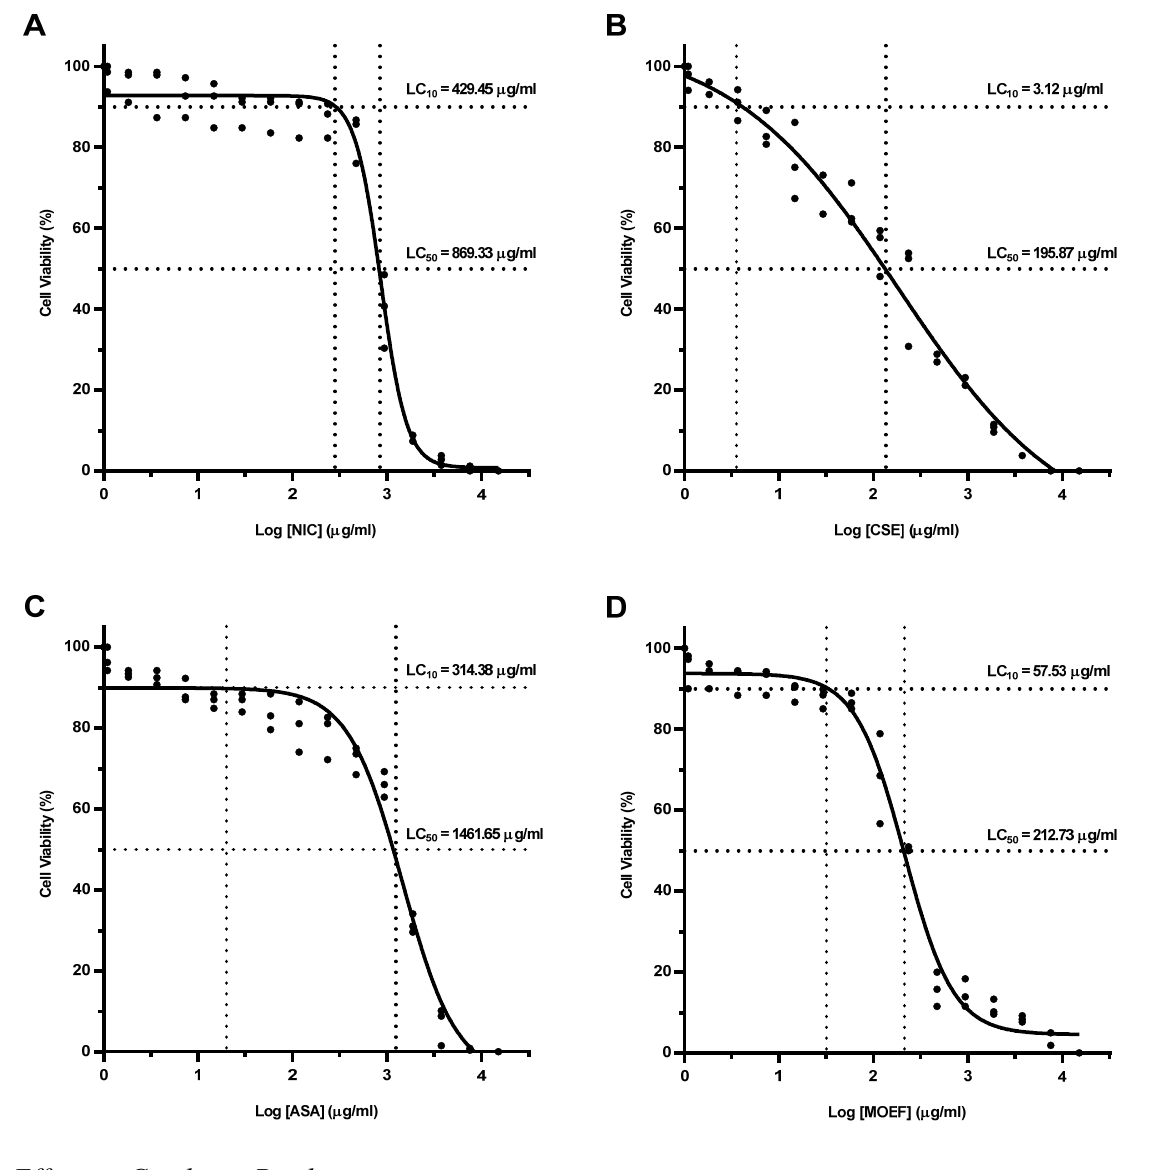
Figure 2. Dose-response curves of each test substances, showing LC nicotine ( A ); CSE; cigarette smoke extract ( B ); ASA; Aspirin ( C ); and MOEF; ethyl acetate fraction from Moringa oleifera extract ( D ). Cells were treated with 2-fold pre-diluted substances for 12 h and tested for their cellular cytotoxicity by neutral red uptake cytotoxicity bioassay. Data of cell viability in triplicate were used to calculate LC LC of each substance by dose-response/sigmoidal curve fitting 10